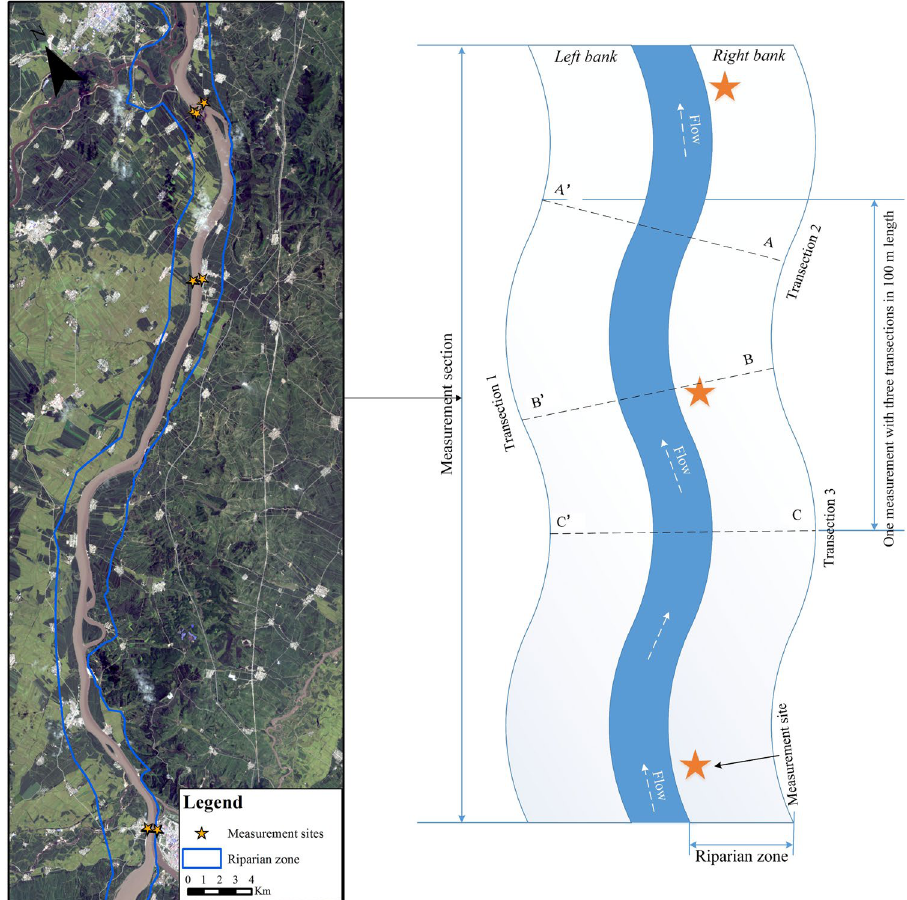
Figure 4. Landsat 8 OLI imagery (left) acquired in September 06, 2015 (U.S. Geological Survey (USGS) Earth Resources Observation and Science (EROS) Center, 2015, Landsat_8 – Path 116 Row: 28 for Scene: LC81160282015249LGN00, Sioux Falls, South Dakota.: U.S. Geological Survey (USGS) Earth Resources Observation and Science (EROS) Center, https://lta.cr.usgs.gov/L8) illustrated example locations of the measurement sites and the layout of field measurements (right). One measurement section had 3–4 measurement sites, one measurement site had three transections with 30 m width × 50 m length measurement area on both side of banks. ArcGIS 10.3 software (http://www.esri.com/software/arcgis) was used to process and map the data by first author (B.